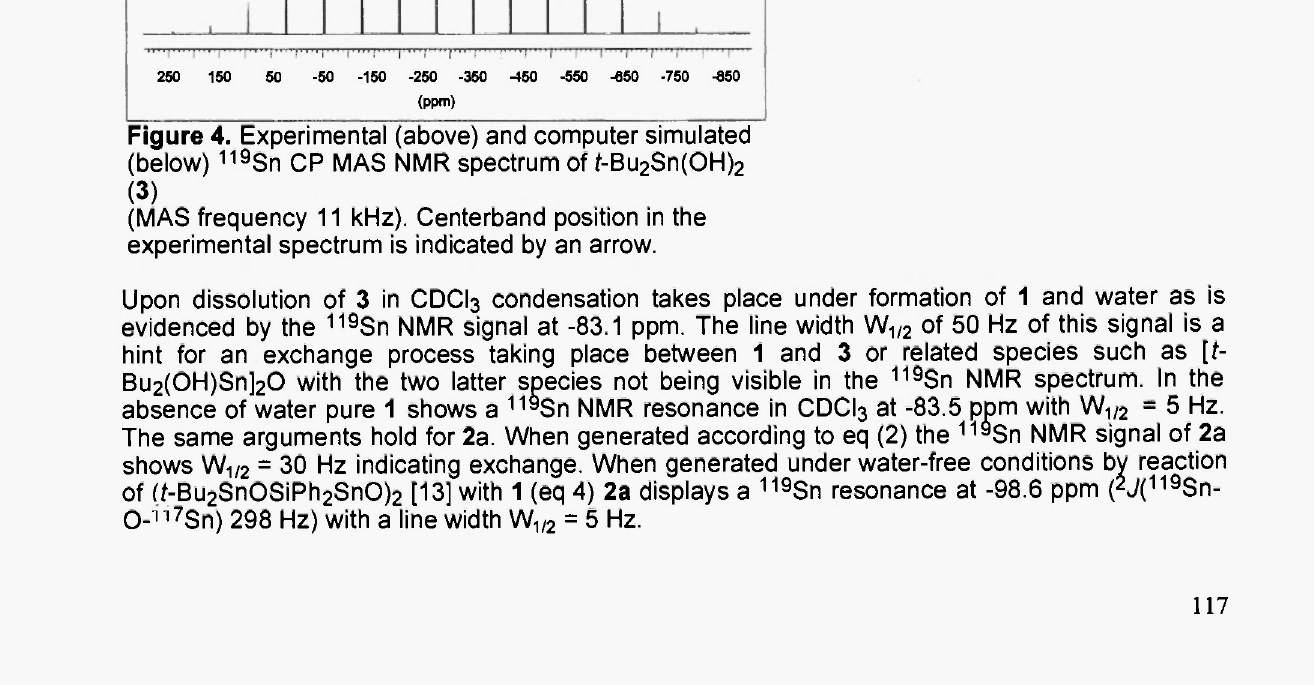
Figure 3. Proposed structure of f-Bu 2 Sn(OH )2 (3).